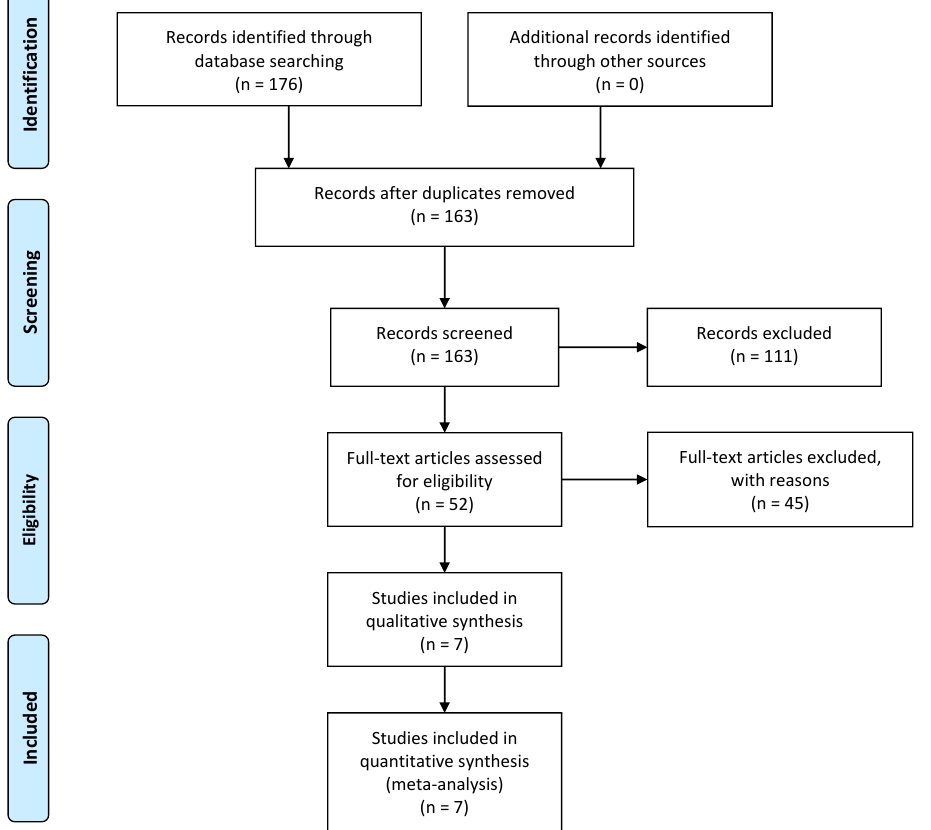
Figure 1. PRISMA diagram showing the study selection process .